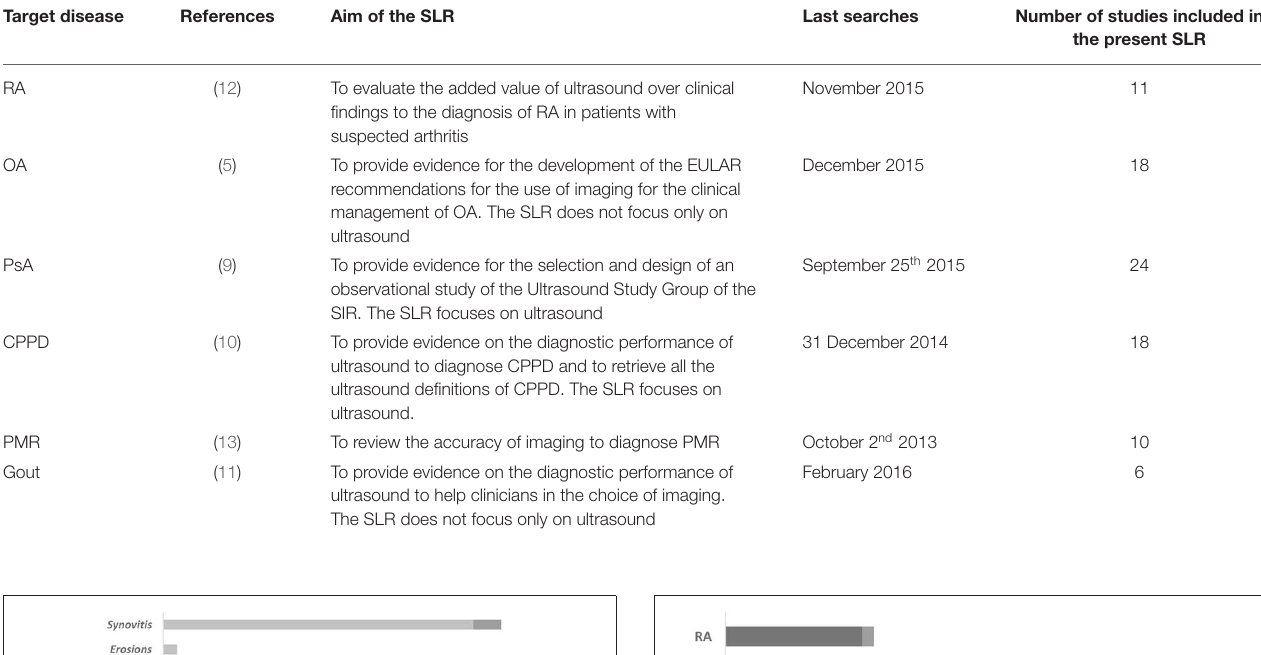
TABLE 2 | Features of the SLRs used as a basis for the present work. Target